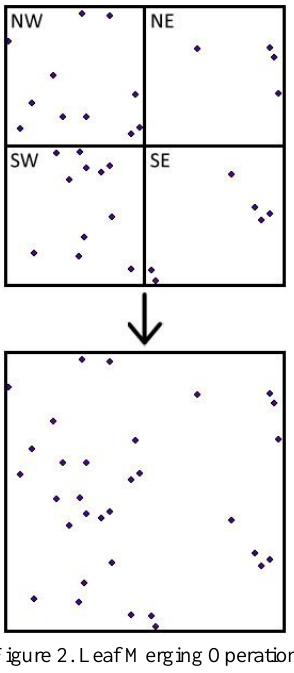
Figure 2. Leaf Merging Operation